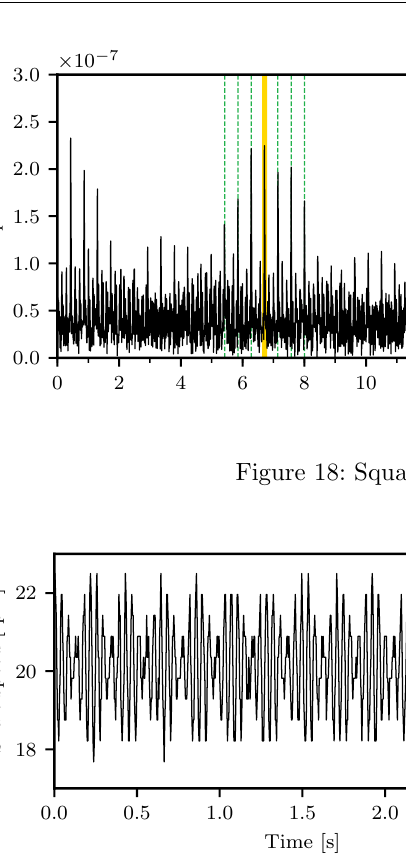
Figure 19: Shaft rotational speed at a reference speed of 20